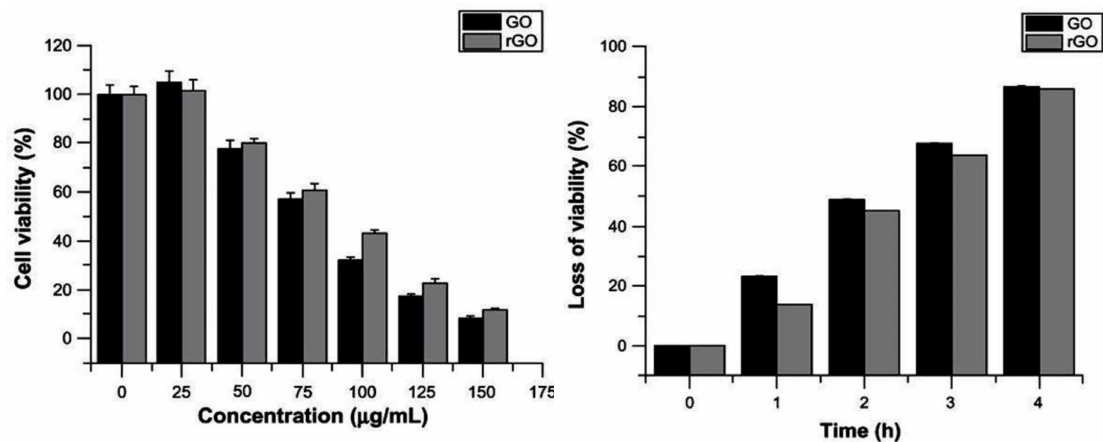
Figure 2. Antibacterial action of graphene oxide (GO) and reduced graphene oxide (rGO) in Pseudomonas aeruginosa . Reproduced from Ref. [44], with permission from Dove Medical Press,